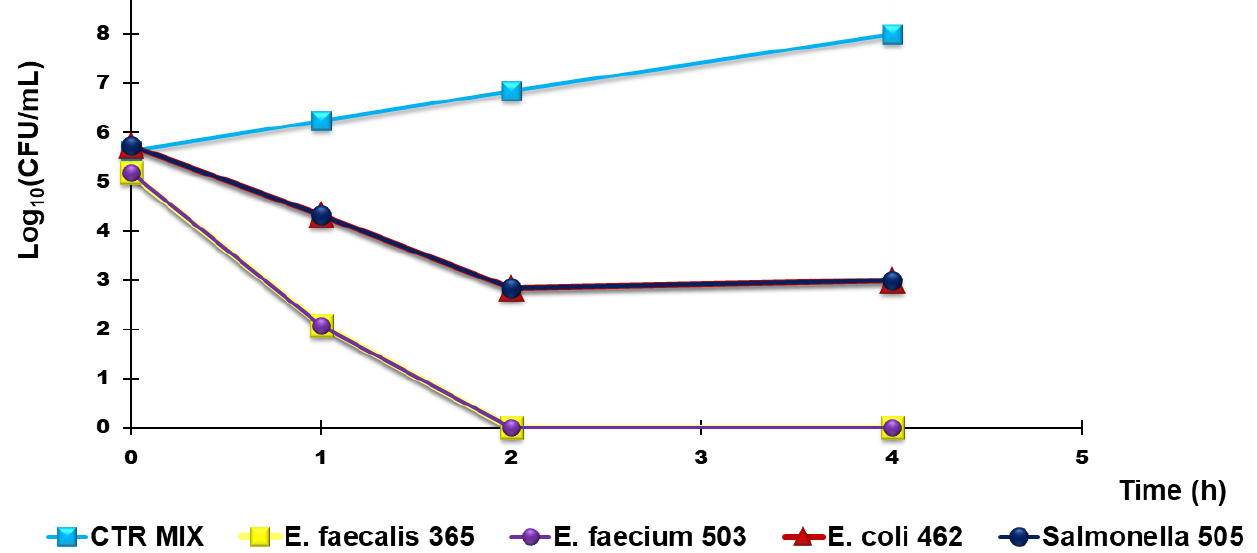
Figure 11. Representative results of TK experiments obtained from treating a mixture of Group B Salmonella species 505, E. coli 462 (New Delhi metallo- β -lactamase producer), E. faecium 503, and E. faecalis 365, with R4 for 4 h.